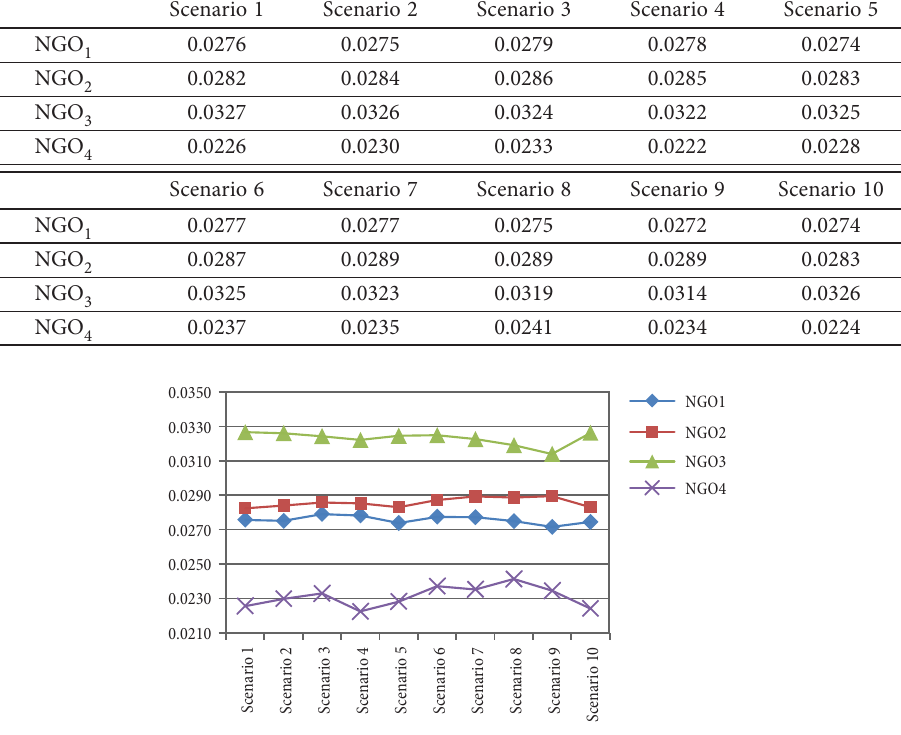
Fig. 4. Model result changes caused by the sensitivity analysis